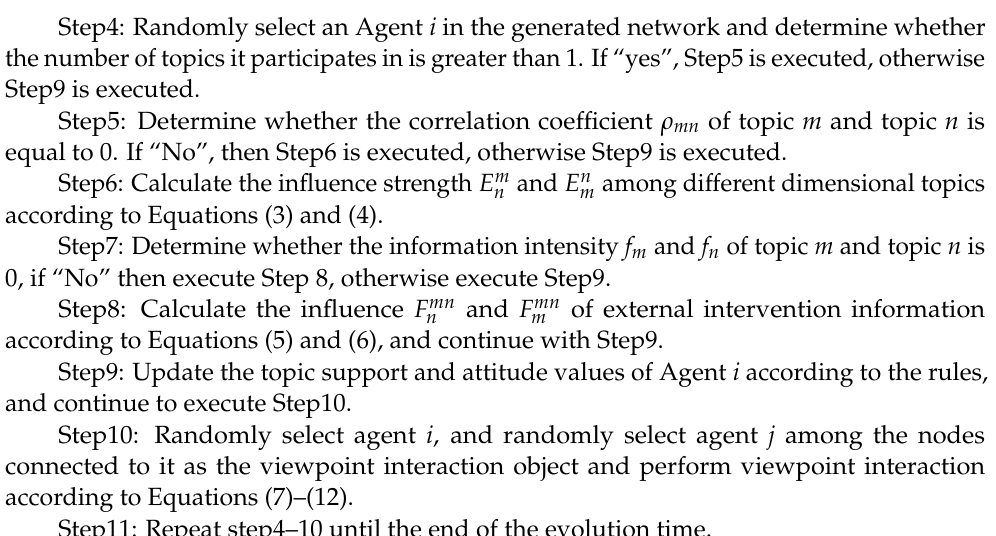
Figure 2. Simulation schematic diagram based on Multi-Agent Monte Carlo